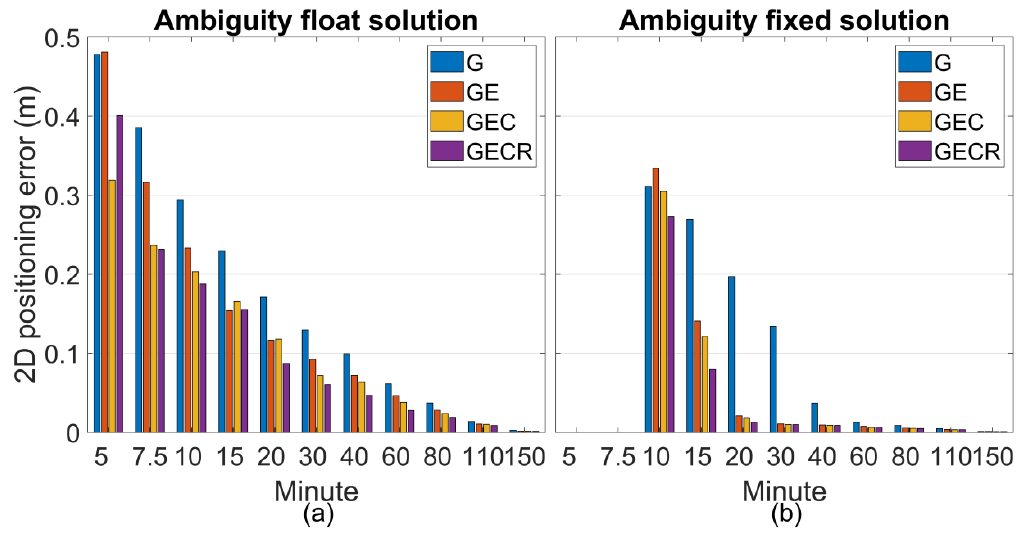
Figure 9. ( a ) Horizontal ambiguity float positioning errors and ( b ) horizontal ambiguity fixed positioning errors of di ff erent combinations in static mode at specific minutes with a 90% probability.